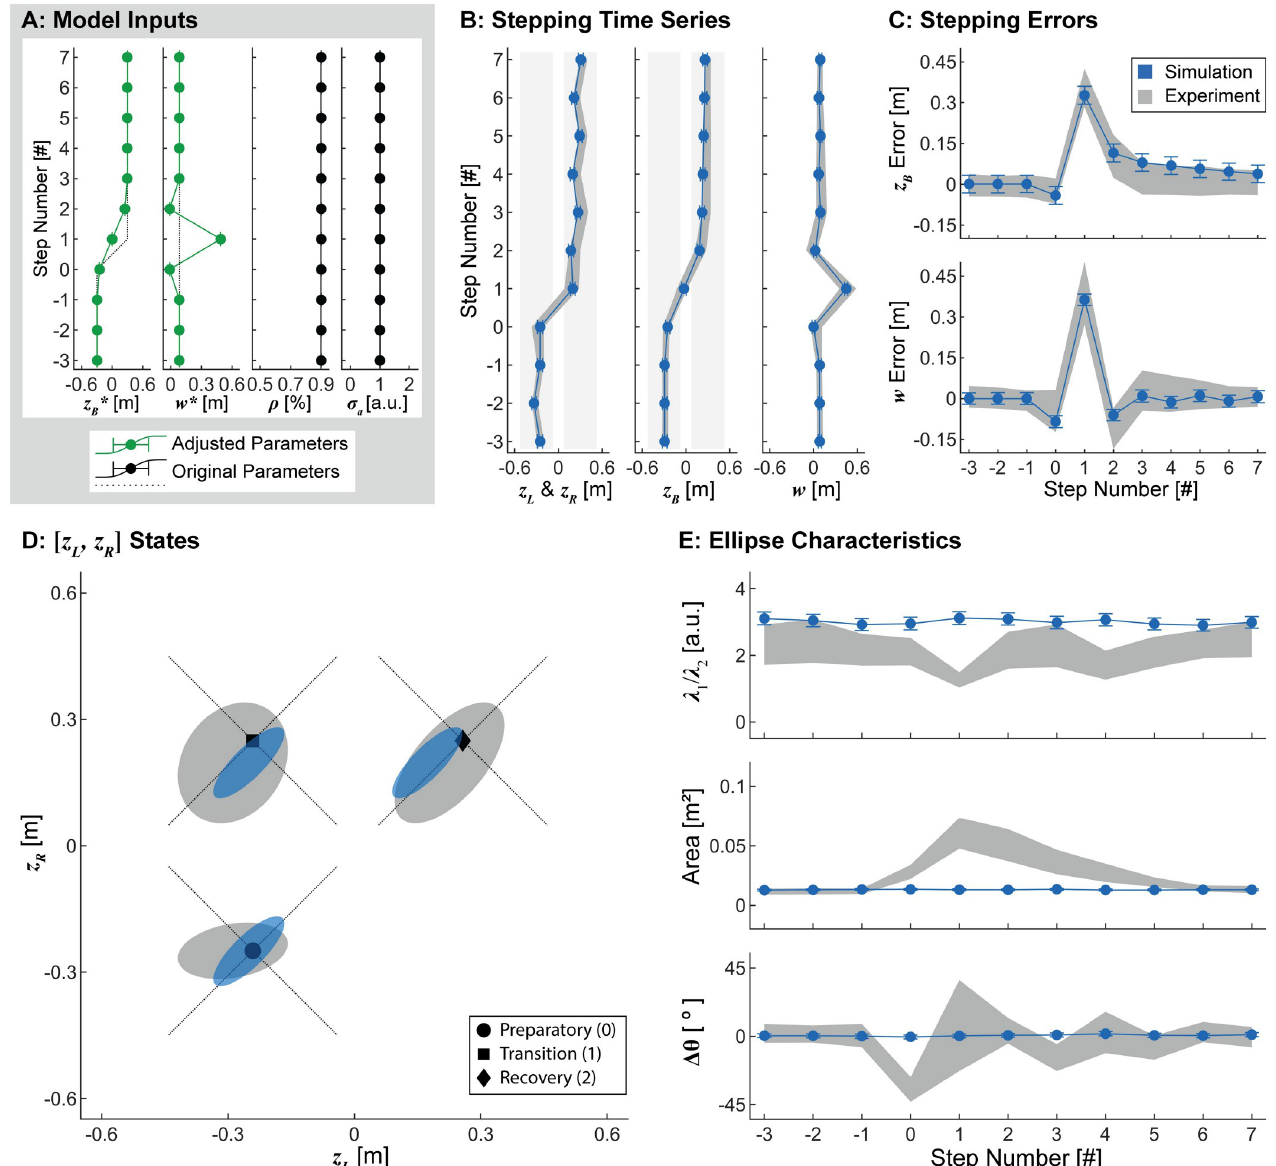
Fig 6. Adaptive Stepping Goals. A) Model parameters. Here, stepping goals, [ z B � , w � ] were updated at each step to reflect an idealized four-step transition strategy. The control proportion ( ρ ) and additive noise ( σ ) were held constant across all steps. B) Stepping time series (mean ± SD) of 1000 simulated lateral a transitions using the parameters in (A). C) Stepping errors (mean ± SD) for the simulations in (B). In both (B) and (C), gray bands indicate the middle 90% range from experimental data. D) Simulated stepping data from the preparatory, transition, and recovery steps projected onto the [ z , z ] plane. Gray ellipses L R represent 95% prediction ellipses at each step from the experimental data. Blue ellipses represent 95% prediction ellipses from the 1000 simulated lateral � and constant- w � GEMs at the preparatory, transition, and recovery steps. E) Ellipse transitions. The diagonal dotted lines indicate the predicted constant- z B characteristics (mean ± SD) at each step (as defined in Fig 5): aspect ratio (top), area (center), and orientation (bottom). Gray bands indicate ± 95% confidence intervals from the experimental data derived using bootstrapping. Adapting the stepping goals alone yielded experimentally plausible stepping time series (B), errors (C), and locations (D), but not stepping distributions (D-E). Thus, adaptive stepping goals are necessary but not sufficient to replicate human stepping during lateral